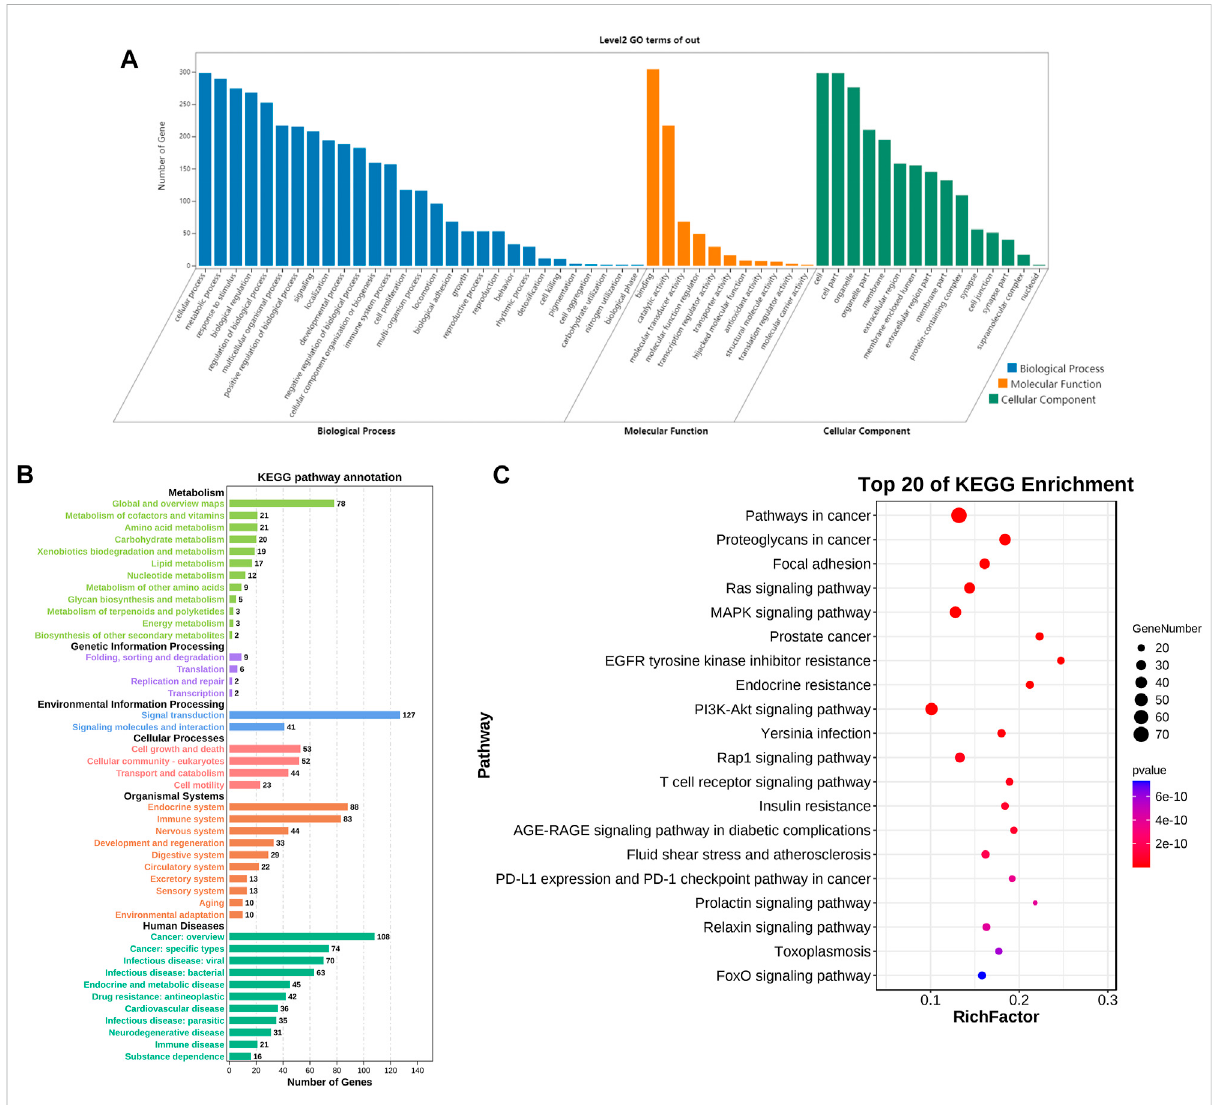
FIGURE 4 GO bio-annotation and KEGG pathway enrichment analysis of GS-Rd for AD treatment. (A) histogram of signi fi cance for GO functional enrichment. (B) Statistics on KEGG pathway enrichment. (C) Top 20 putative targets of KEGG pathway enrichment.